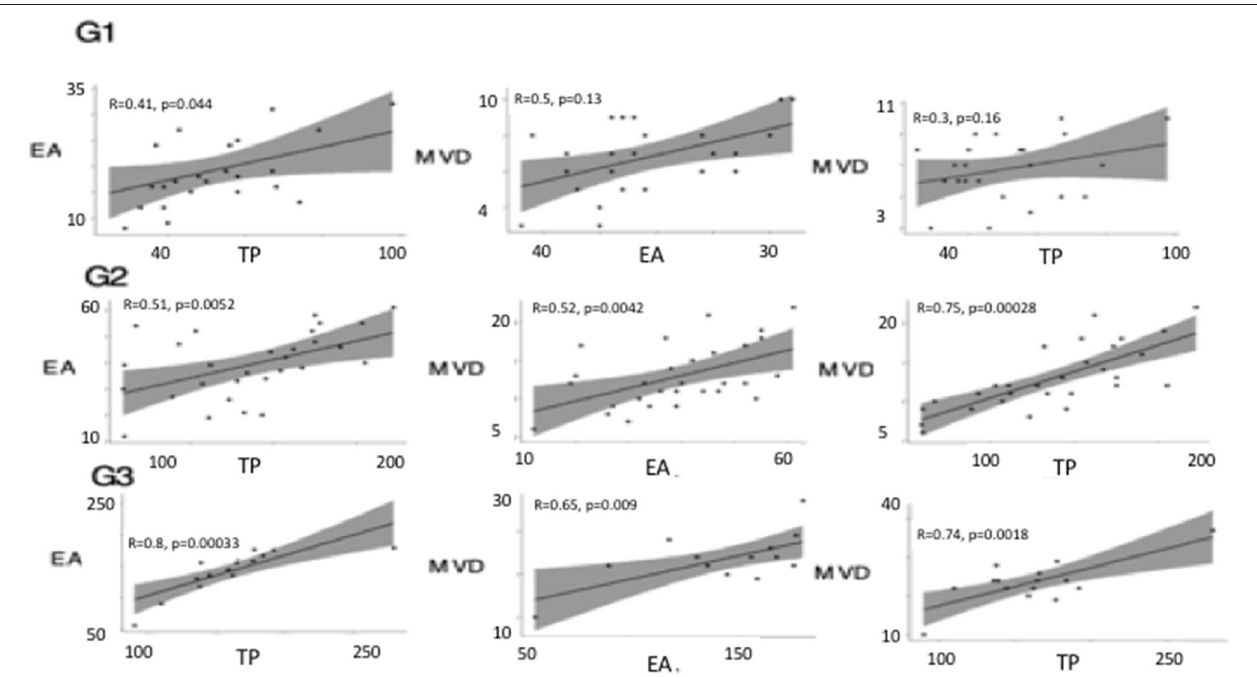
FIGURE 7 | Linear correlation plots between thymidine phosphorylase (TP), micro-vessel density (MVD), and endothelial area (EA) performed in different tumor grade (G1, G2, G3). Linear correlation analysis and two-way ANOVA showed between TP and EA, and, MVD and TP, and MVD and EA a coefficient of correlation (r) > 0.5 ( p < 0.05) in G3. A significant correlation was calculated between variables in G2.